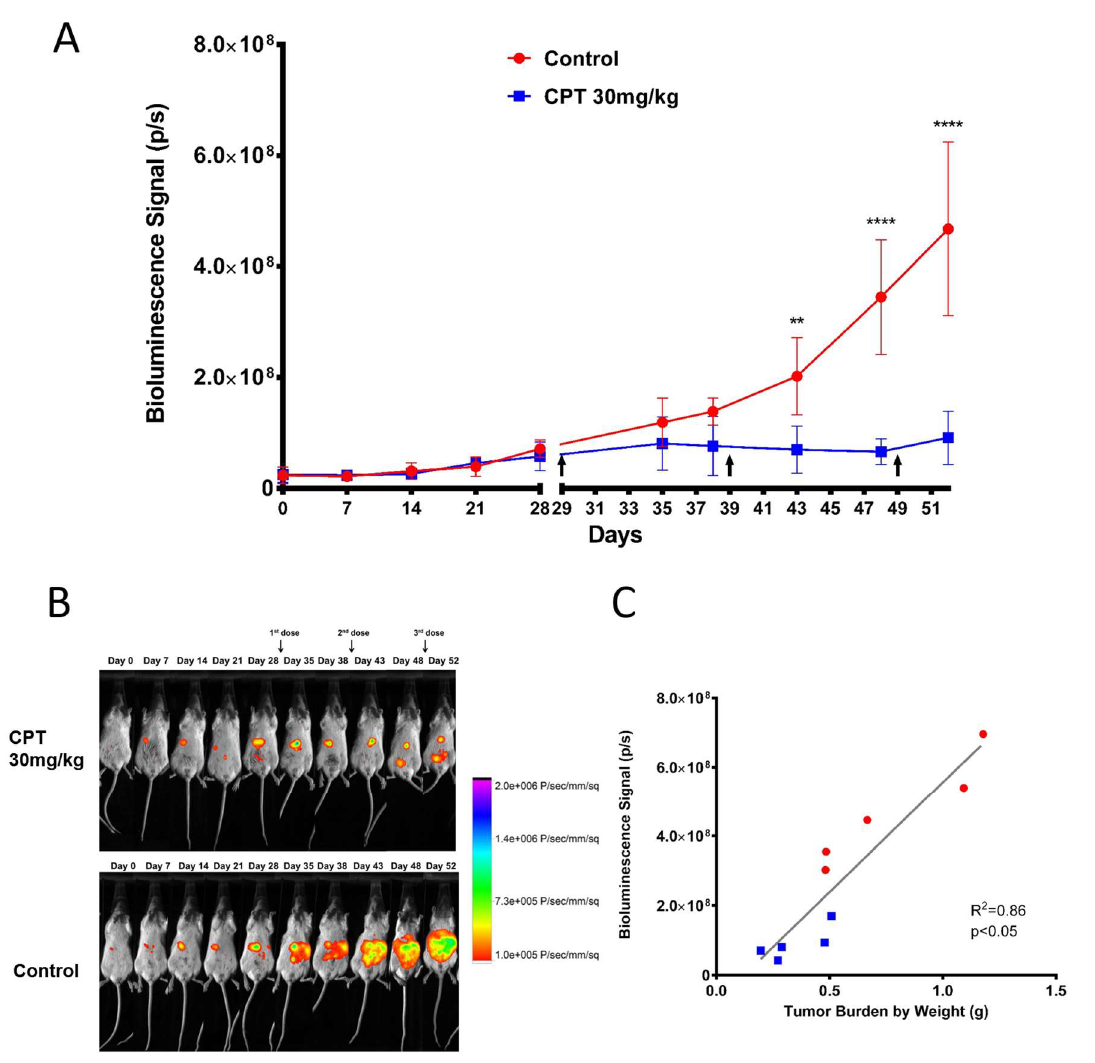
Figure 6 Figure 6. E ff ect of carboplatin on the growth of OVCAR8 luc xenografts in response to intraperitoneal carboplatin (30 mg / kg). Treatment was initiated at day 29, 39 and 49. Mice were sacrificed on day 52 after imaging. ( A ) Quantification of bioluminescence signal (photon / s), data are shown as mean ± SD, n = 5. ( B ) Representative images of successive imaging of the same animal in each group, color scale bar indicates photon / s / mm 2 of the field. ( C ) Correlation of bioluminescent signal with tumor weight for treated (blue dots) and untreated (red dots) mice. Statistical analysis was done by two-way ANOVA with Sidak’s test, n = 5 mice were inoculated and treated for each group. ** p < 0.01; **** p <